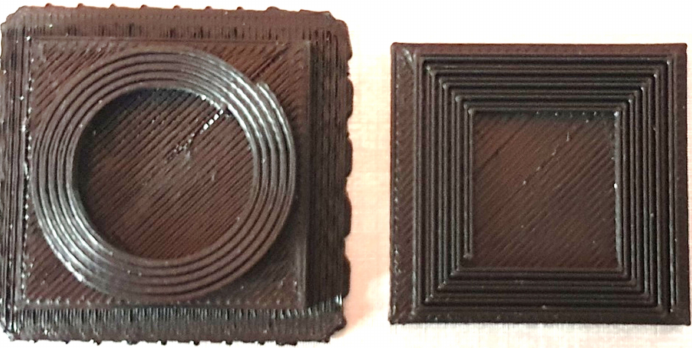
Figure 3. Defects occurring on the base polymer despite successful coils printing.